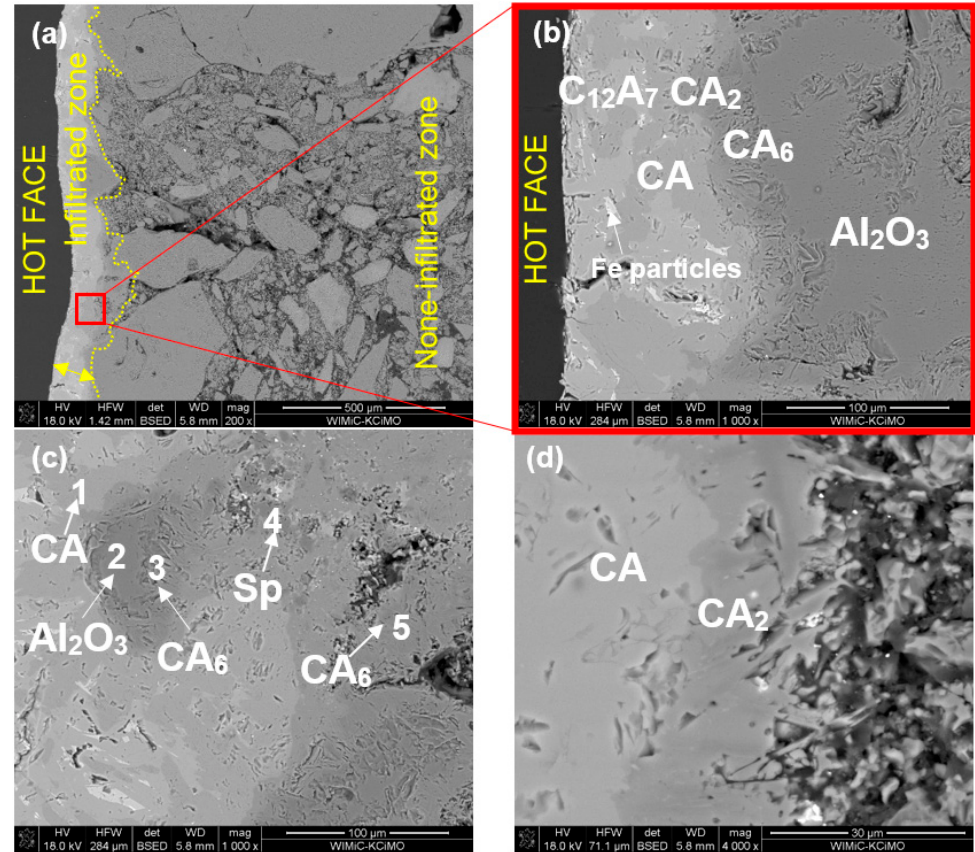
Figure 12. SEM images of sample Al-1-1 corroded by slag R (1350 °C, 10 h); ( a , b ): hot-face (slag/refractory interface); ( c , d ) higher magnification of interface zone.